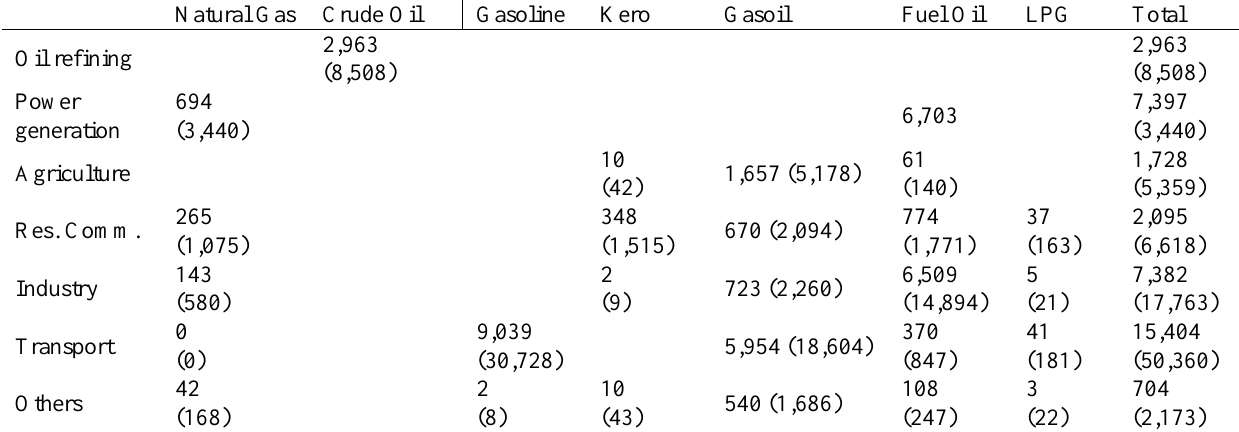
Table 2. Damage caused by the sector in 2001 (and 2019) bn